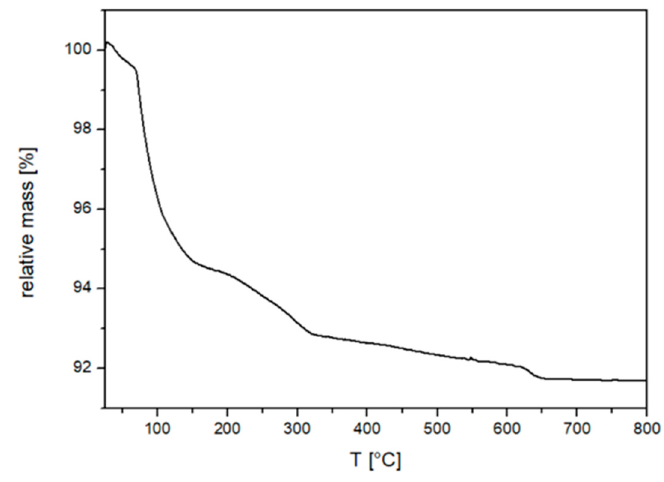
Figure 3. TGA curve of Fe 3 O 4 @CA MNPs.